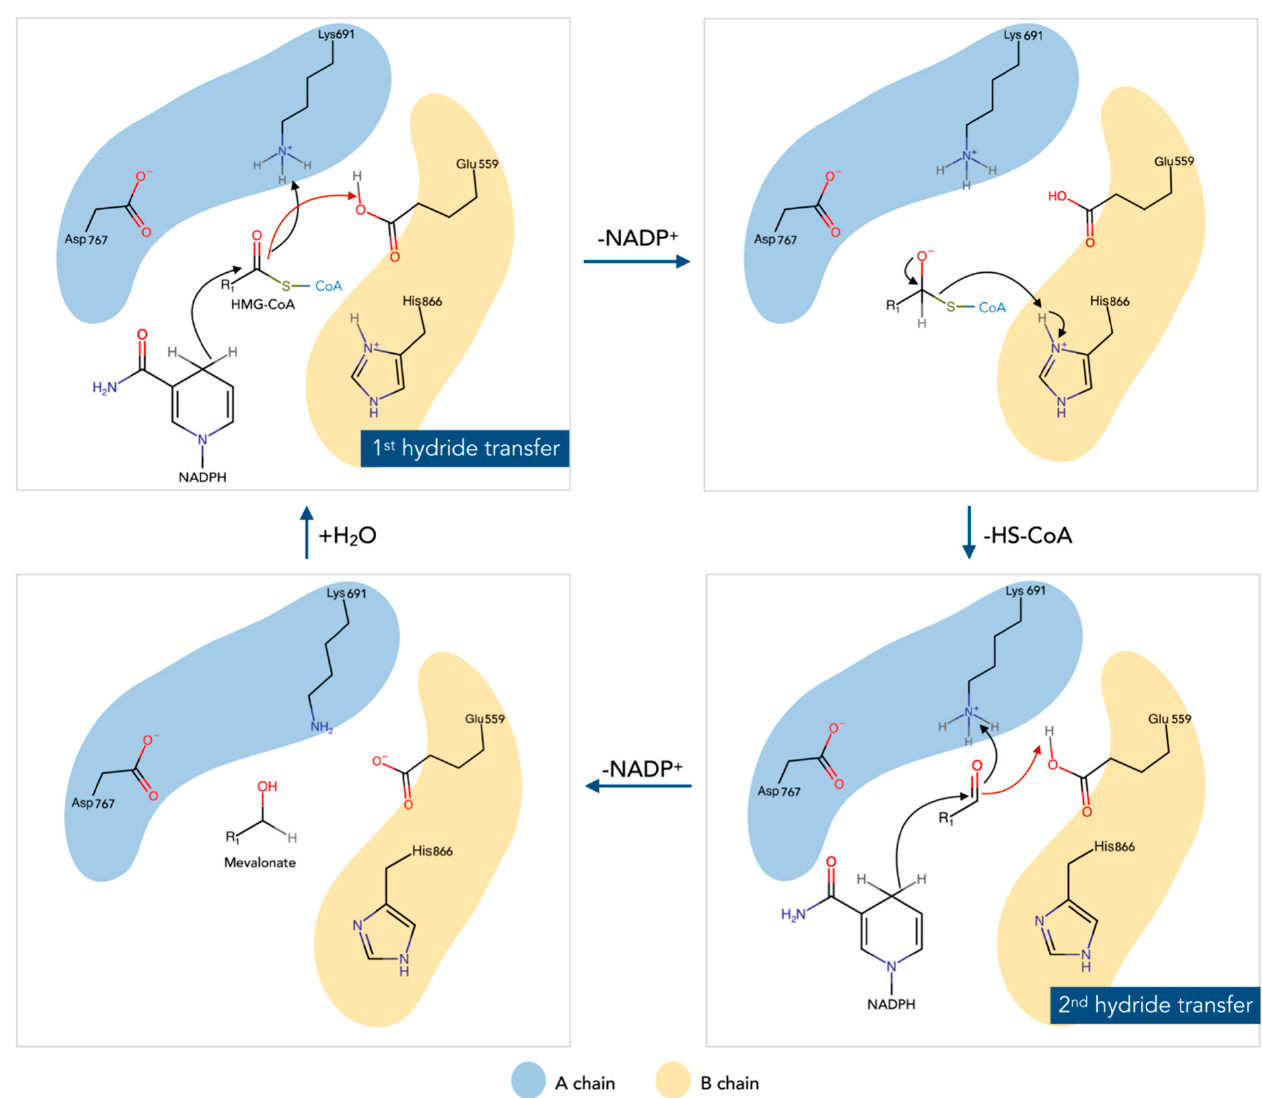
Figure 1. The reaction mechanism catalyzed by the HMG-CoA reductase based on the previous studies of Oliveira et al. [20] and Haines et al. [12], as described in detail in [21]. His866/His405 protonates -SCoA, whereas Lys691\Lys639 ( - ) or Glu559/Glu98 ( - ) is a proton donor after the hydride transfer. Asp767 corresponds to Asp715, and Glu559 corresponds to Glu98 in the current study.